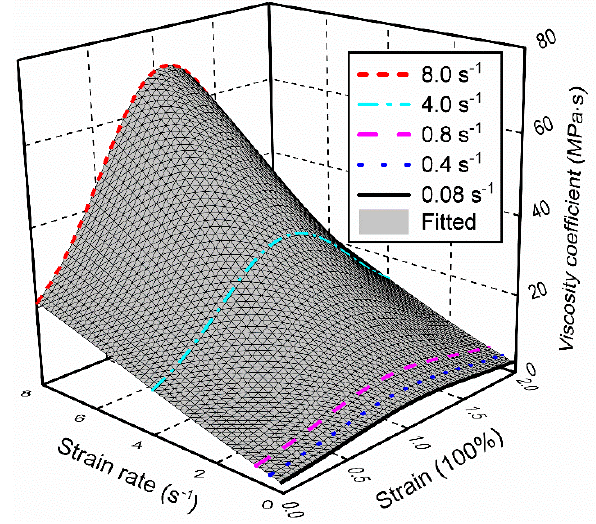
Figure 11. Experimental and fitted results of the viscosity coefficient.